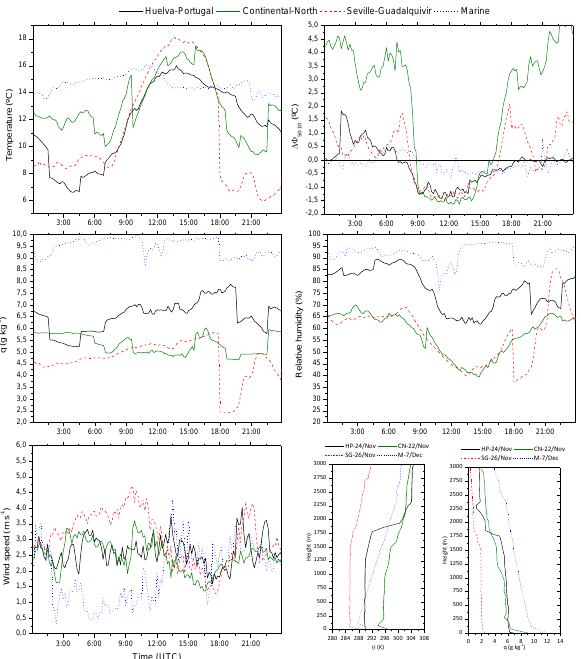
Fig. 5. Average diel profiles of temperature, potential temperature difference, specific and relative humidity and wind speed from the four sectors of origin. Vertical profiles of potential temperature and specific humidity obtained in the afternoon soundings under Huelva–Portugal (H–P on 24 November), continental–north (C–N on 22 November), Seville–Guadalquivir (S–G on 26 November) and marine (M on 7 December) flows.